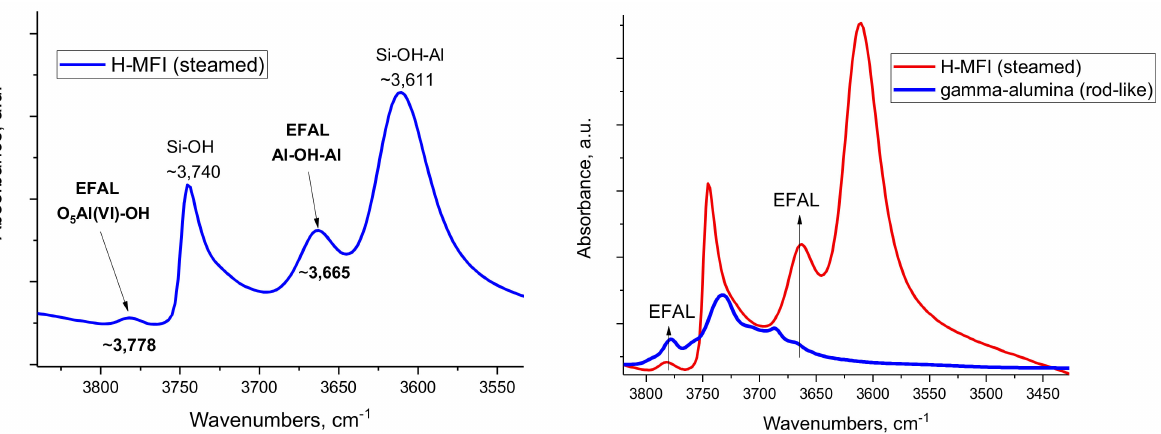
Figure 1. FTIR spectra of MFI and γ -Al 2 O 3 catalyst materials. ( Left ) FTIR spectrum of the OH region of steamed H-MFI sample. ( Right ) FTIR spectrum comparison of the OH regions of steamed H-MFI and rod-like gamma alumina